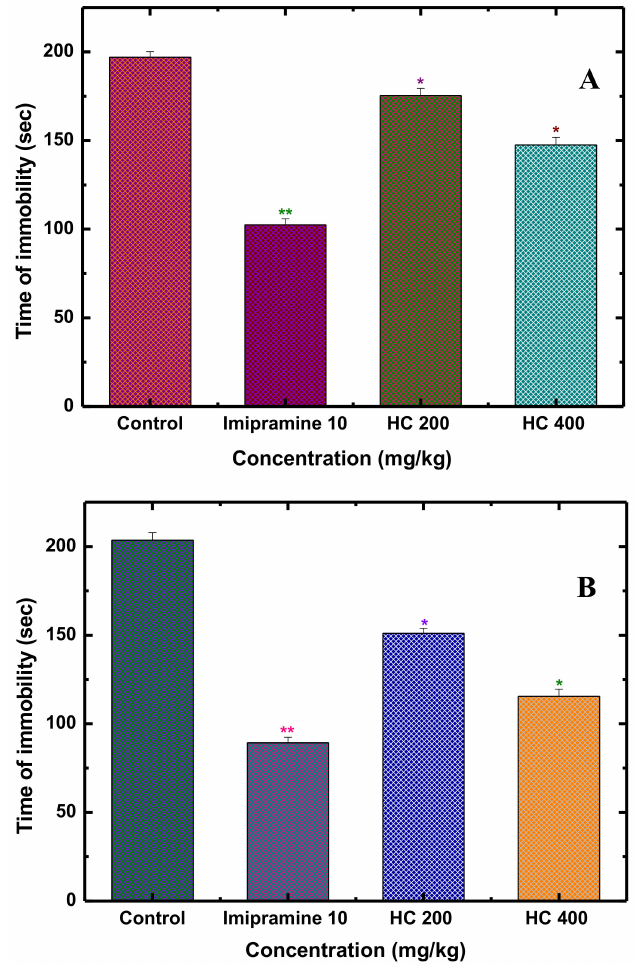
Figure 4. Antidepressant activity of MEHC on forced swimming ( A ) and tail suspension ( B ) tests in mice. Results are expressed in mean ± S.E.M. (* p < 0.05) and (** p < 0.01), significantly di ff erent from control; ANOVA followed by Dunnett’s test ( n = 6, per group). MEHC: methanol extract of Holigarna caustica leaves; HC 200, methanol extract of H. caustica 200 mg / kg; HC 400, methanol extract of H. caustica 400 mg / kg; Reference drug imipramine hydrochloride (10 mg /